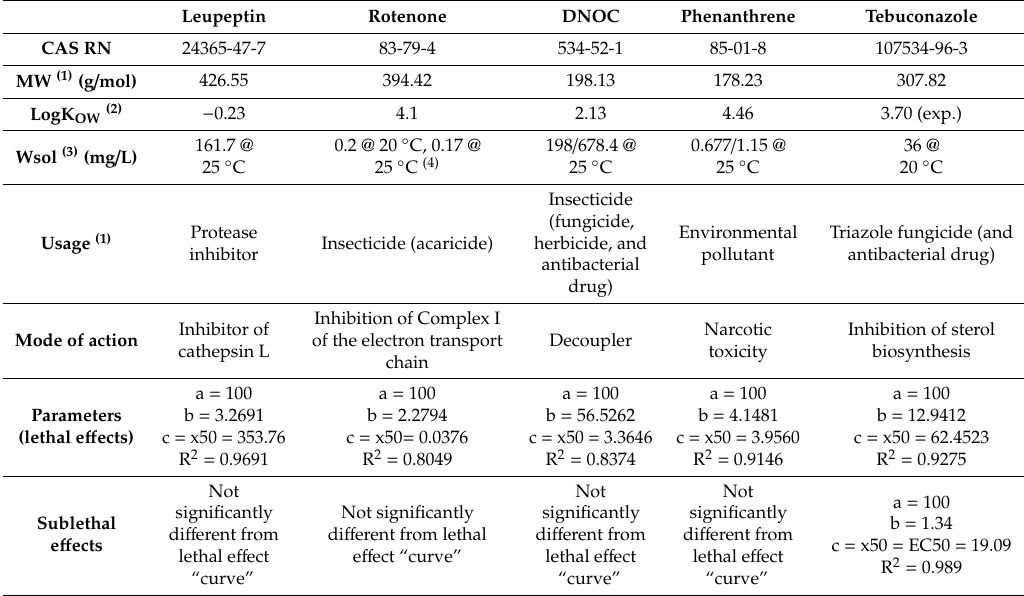
Table 1. Chemical identities, physicochemical properties and model parameters from concentration– effect relationships established for lethal (FET) and sublethal effects after the exposure of zebrafish embryos to the five test substances.